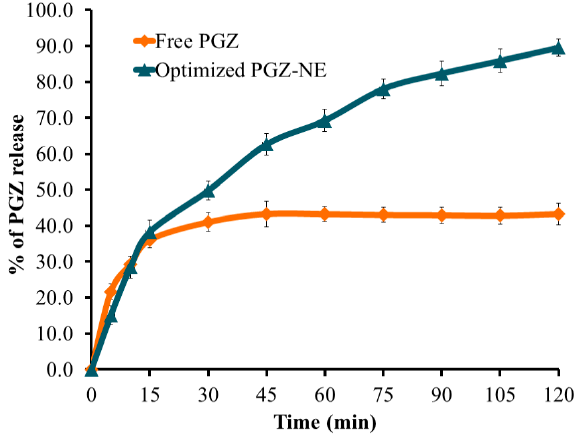
Figure 7. Profile illustrating in vitro release of optimized PGZ-loaded NE formulation.